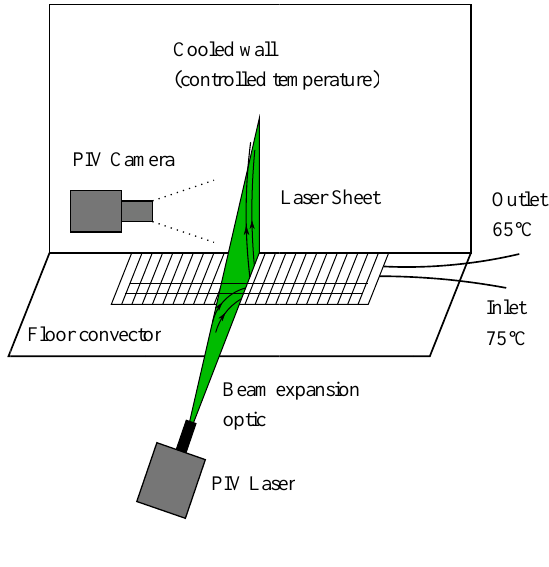
Fig. 3. PIV Measurement.